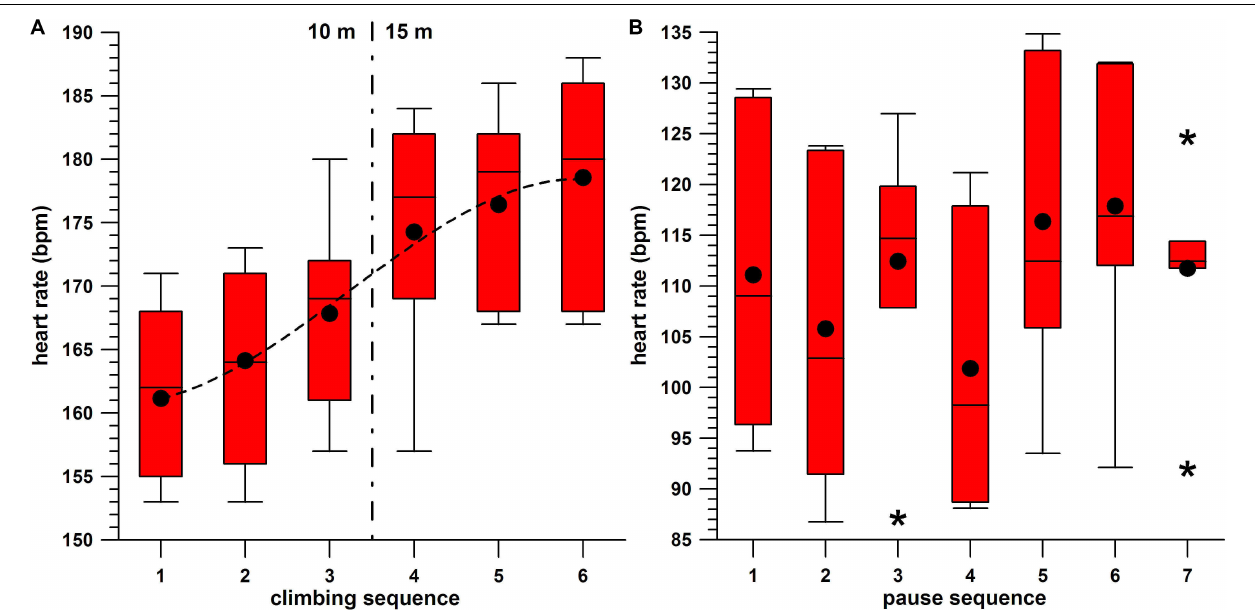
FIGURE 4 | (A) Peak heart rate against the sequence of the six climbs per participant, box-and-whisker plots, average ( • ), and cubic fit function (dashed line); (B) pause heart rate against the sequence of the seven pauses per participant, box-and-whisker plots, average ( • ), and outliers (*).